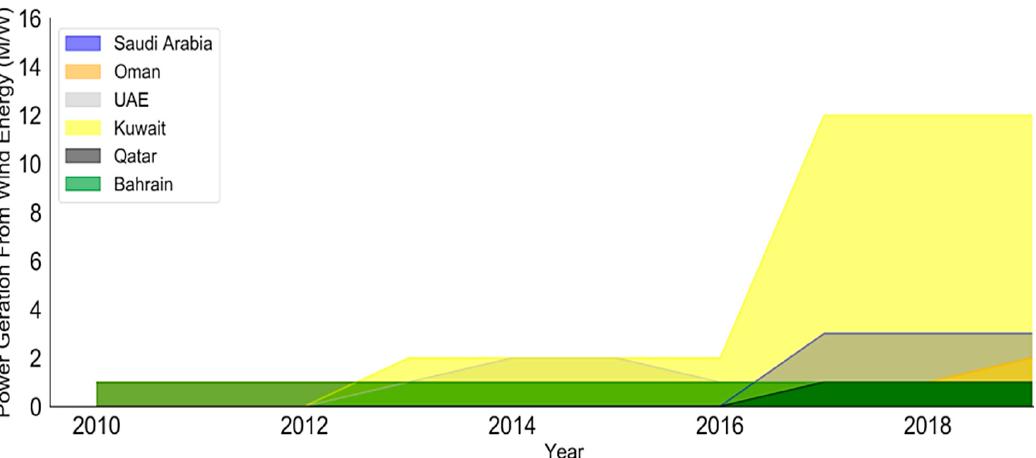
Figure 12. Power installed capacity from wind energy in GCC region, 2010–2019.